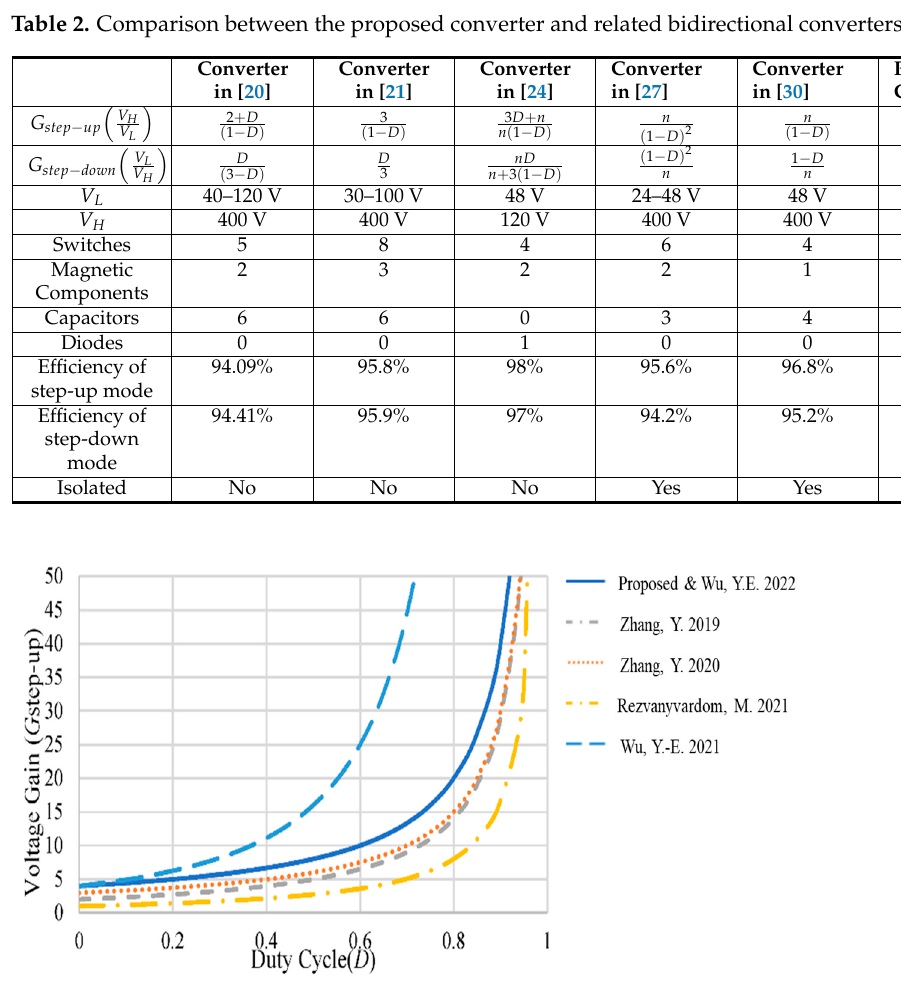
Table 2. Comparison between the proposed converter and related bidirectional converters.